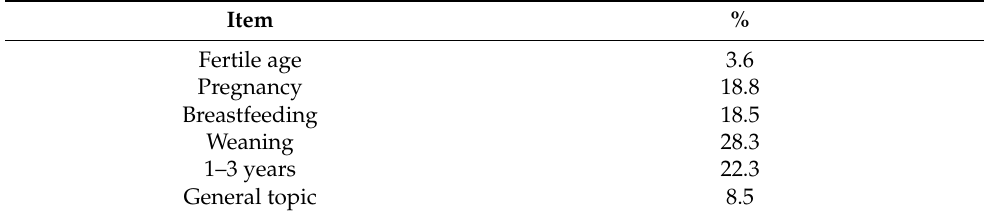
Table 3. Percentage of question to each